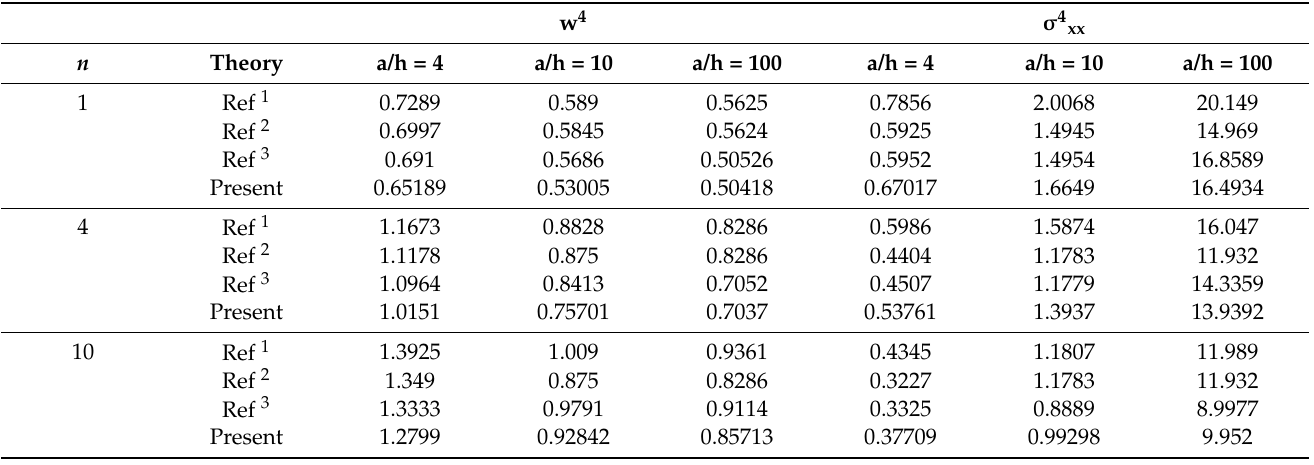
Table 7. The variation in non-dimensional central displacement and axial stress subjected to sinu- soidal loading. w 4 σ 4